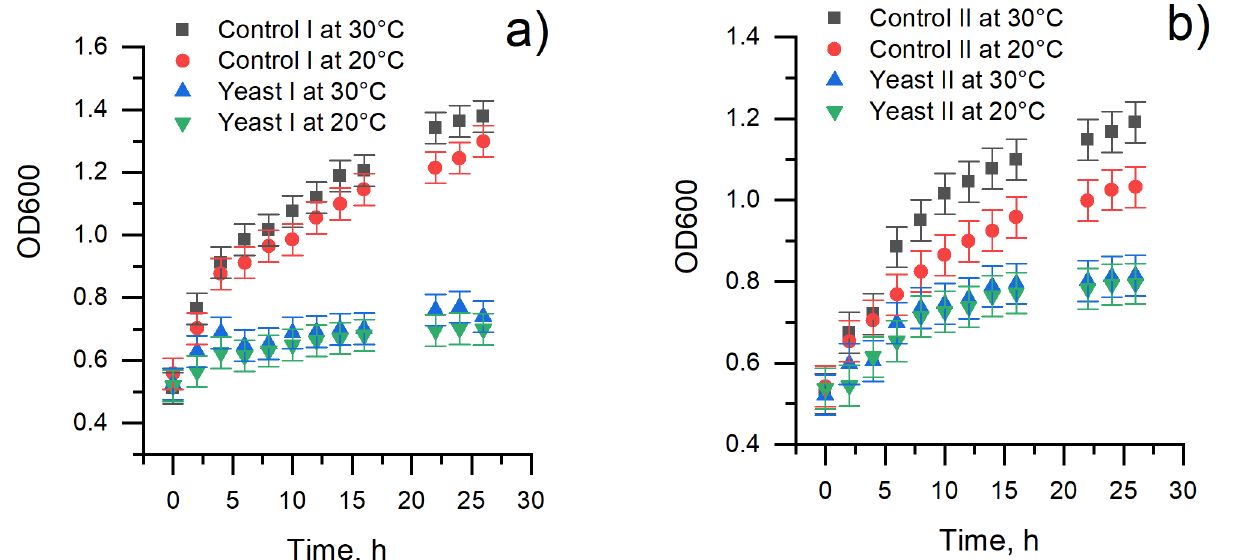
Figure 1. Variation of optical density (OD) during the determination of growth curves of yeast. ( a ) A comparison of growth curves: (i) yeast I— Saccharomyces cerevisiae with 3.75 mM menadione (MD); control I— Saccharomyces cerevisiae in the liquid YPG agar medium; ( b )—a comparison of growth curves: (ii) yeast II—baker’s yeast with 3.75 mM MD; control II—baker’s yeast in the liquid YPG agar medium.